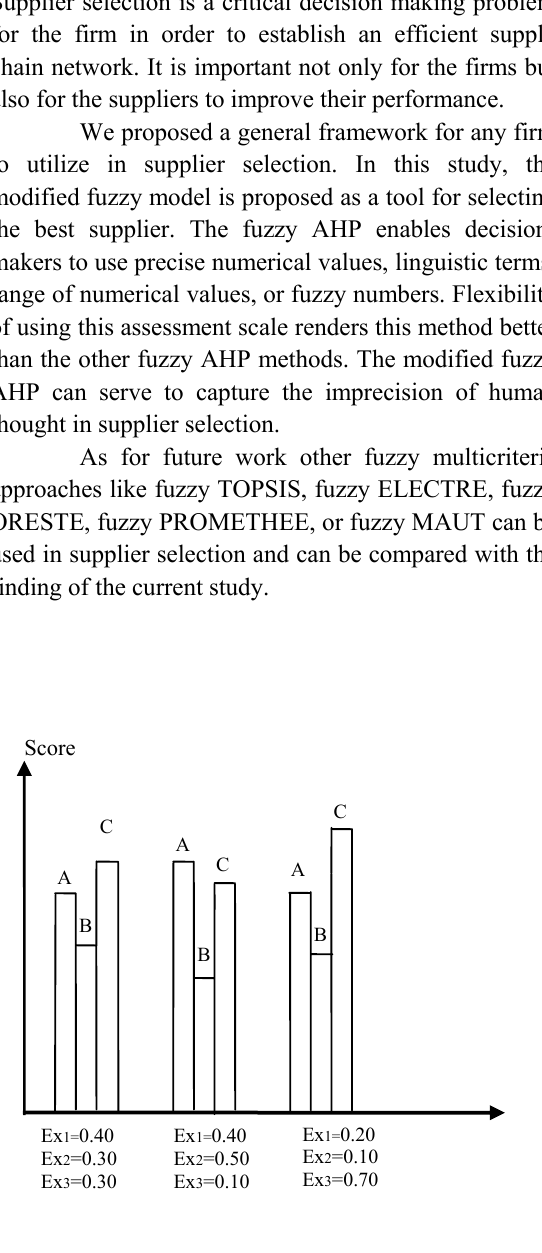
Fig. 5. Sensitivity analysis